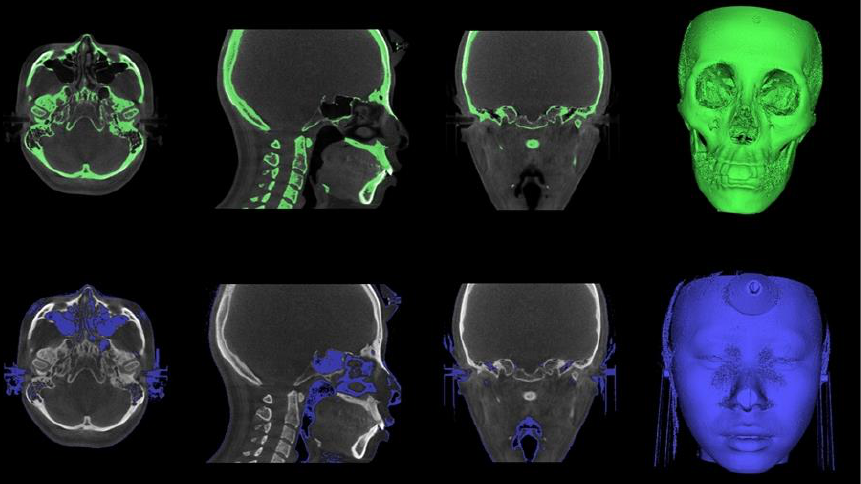
Figure 2. Cephalometric reference planes and measurements. Yellow, vertical reference line (vert T); Blue, ( a ) S-N ( b ) U1-SN ( c ) mandibular plane ( d ) IMPA; Red, (1) U1 apex (2) L1 tip (3) U1 tip (4) L1 apex. Incisal movements were quantified by measuring the horizontal distance from incisor tip and apex to vert T, which is Nasion perpendicular line.